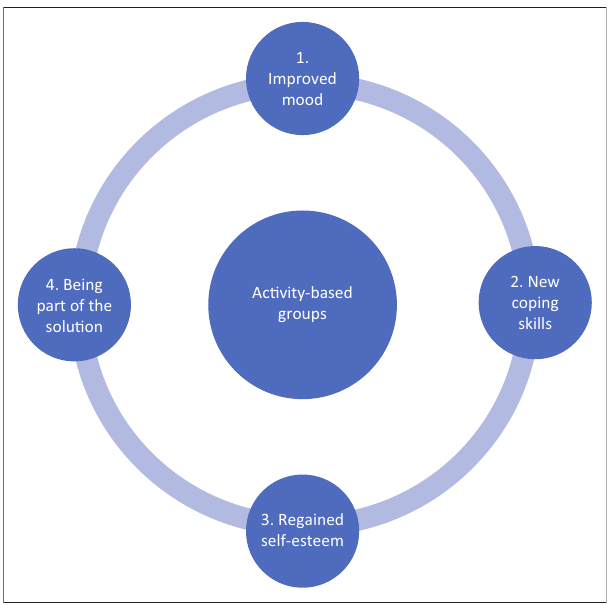
FIGURE 1: Inpatients’ perceptions of occupational therapy activity-based